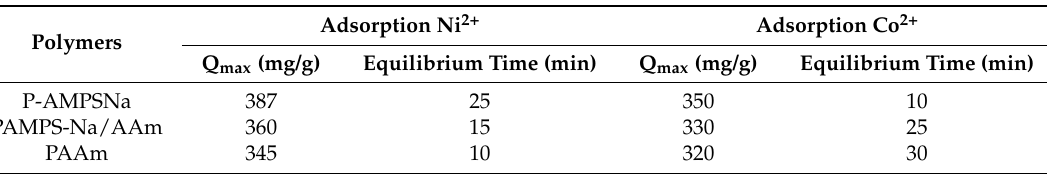
Table 4. Adsorption data of silica-nanogel composites for Co and Ni cations from their aqueous solutions at pH 9, ionic strength 1 M, and temperature of 25 °C.